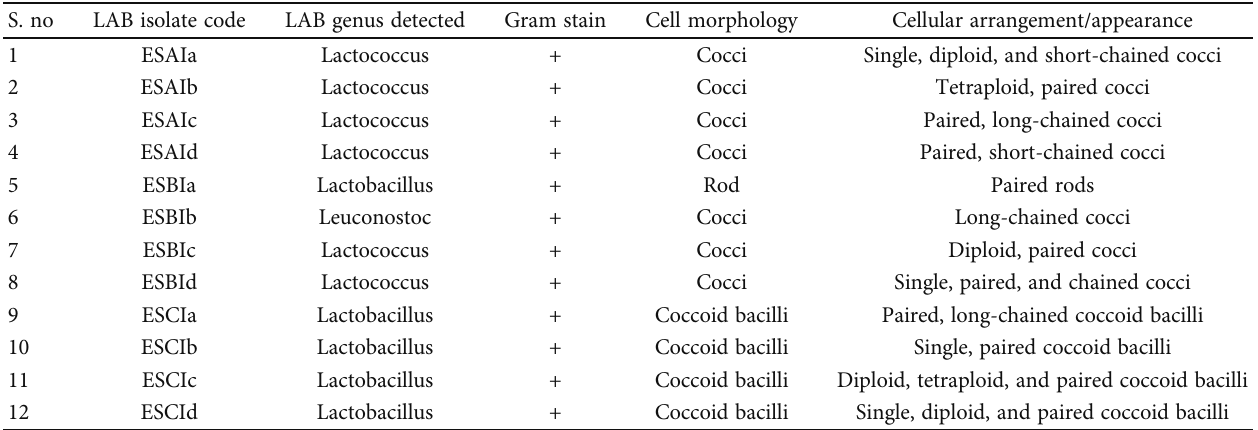
Table 2: Biochemical and physiological characteristics of LAB isolated from Ergo samples, Jimma town, southwest Ethiopia. S.